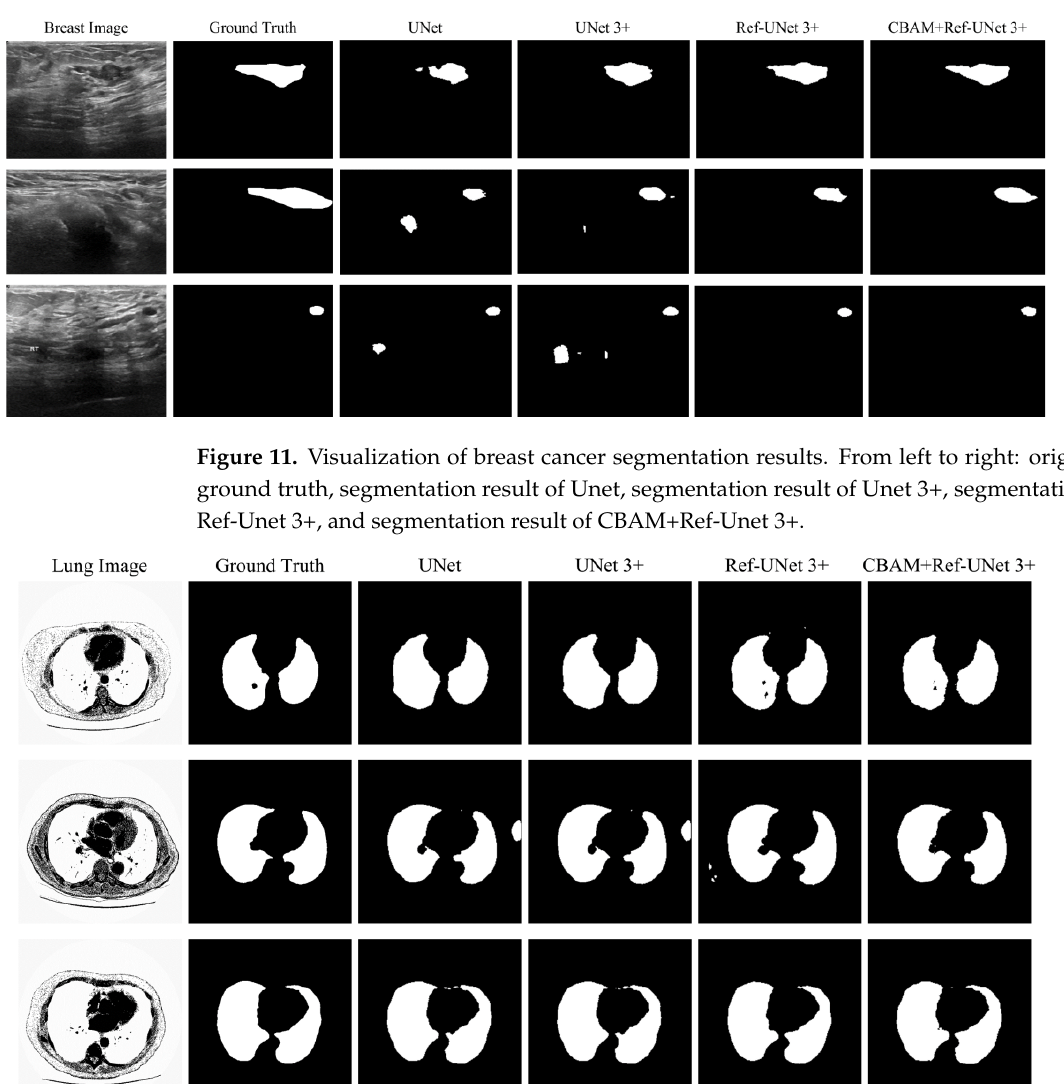
Figure 10. Visualization of skin cancer segmentation results. From left to right: original image, ground truth, segmentation result of Unet, segmentation result of Unet 3+, segmentation result of Ref-Unet 3+, and segmentation result of CBAM+Ref-Unet 3+.